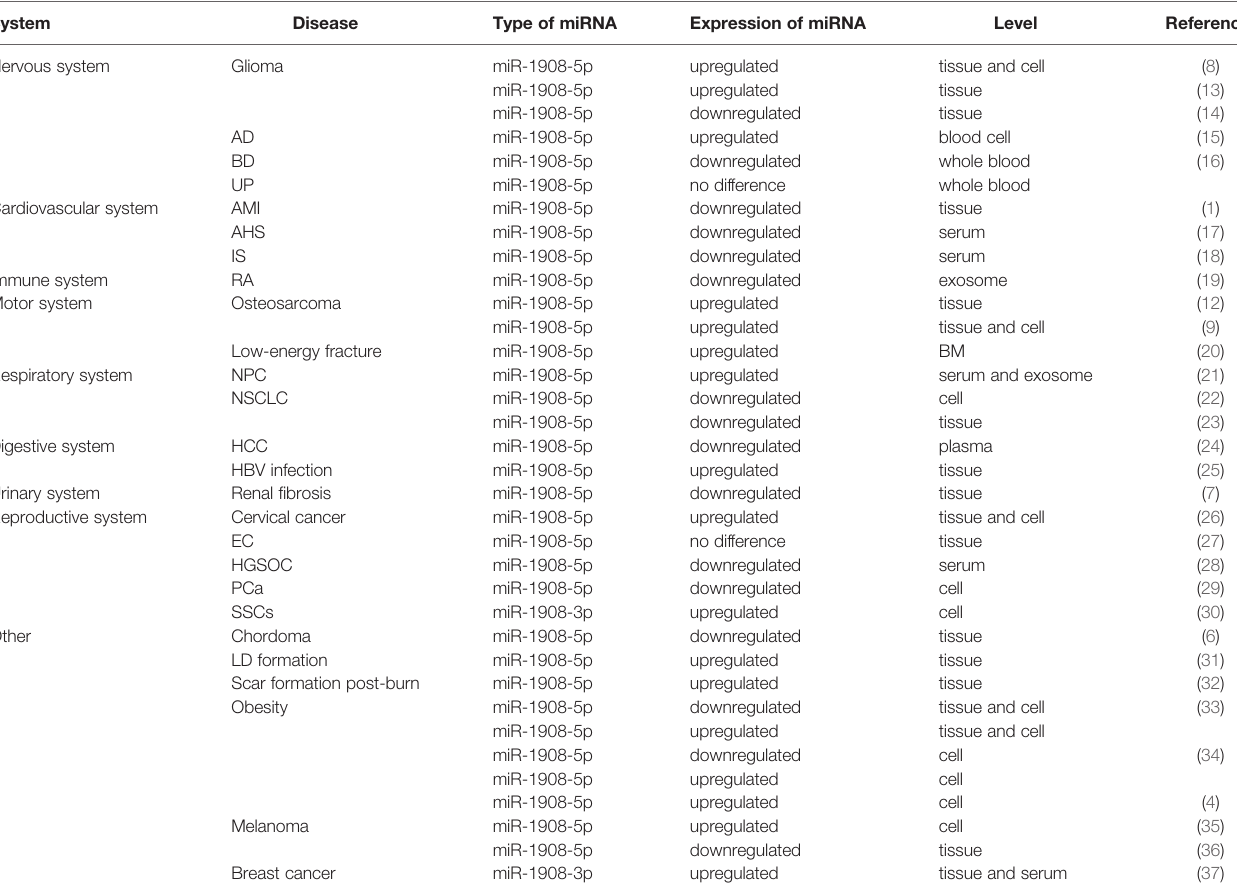
TABLE 1 | Aberrant expression of miR-1908 in cancers and other